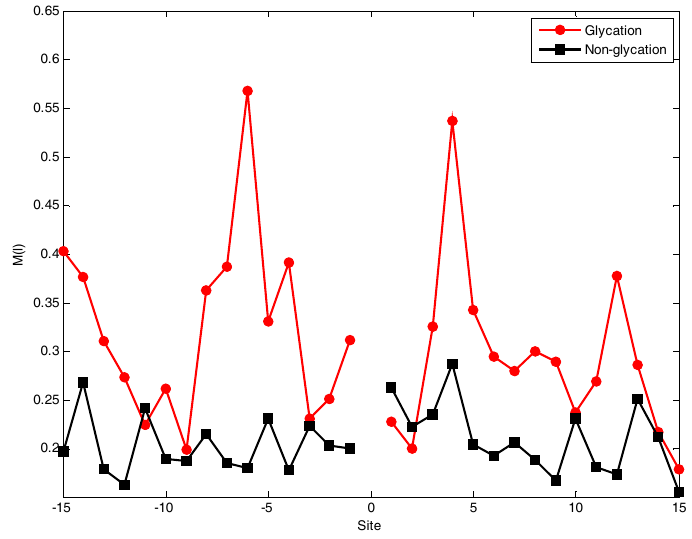
Figure 2. The position conservation M(l) value around the glycation and non-glycation sites.